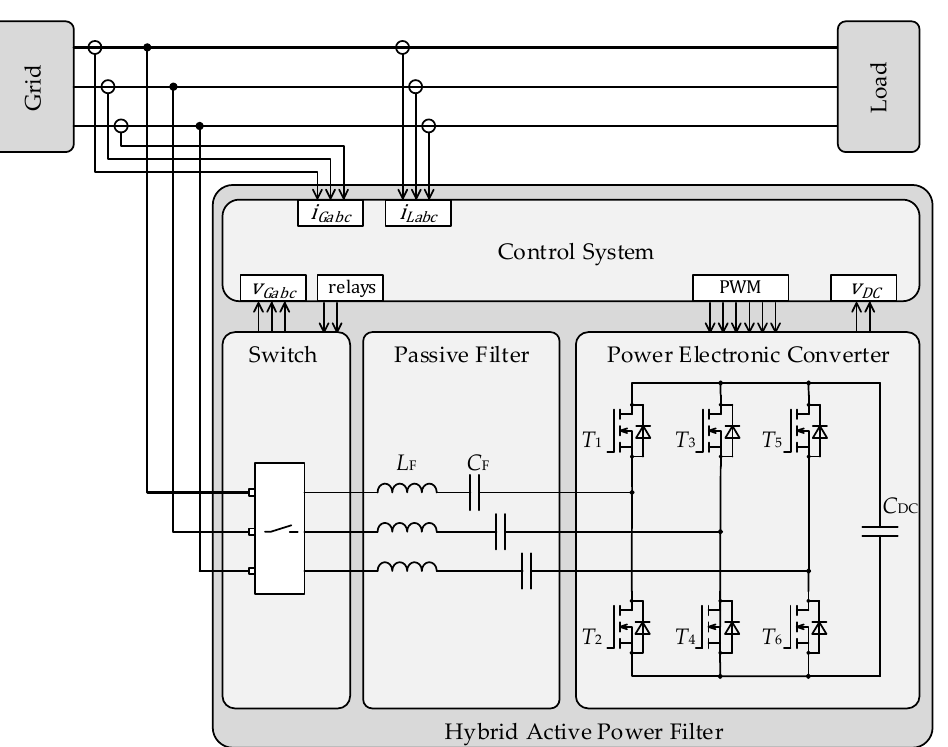
Figure 2. Topology of the proposed hybrid active power filter